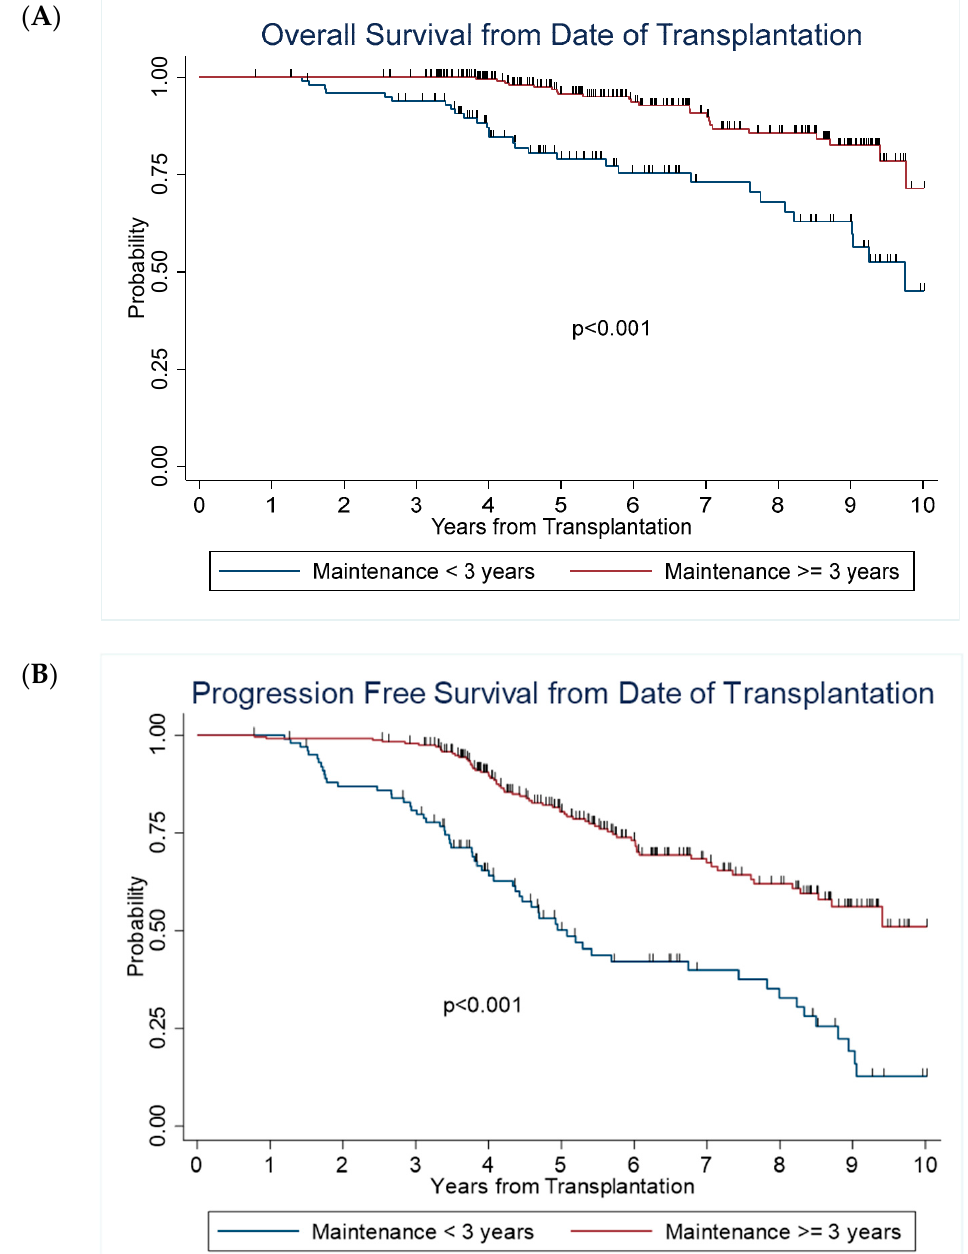
Figure 1. Survival outcomes from the date of transplantation.